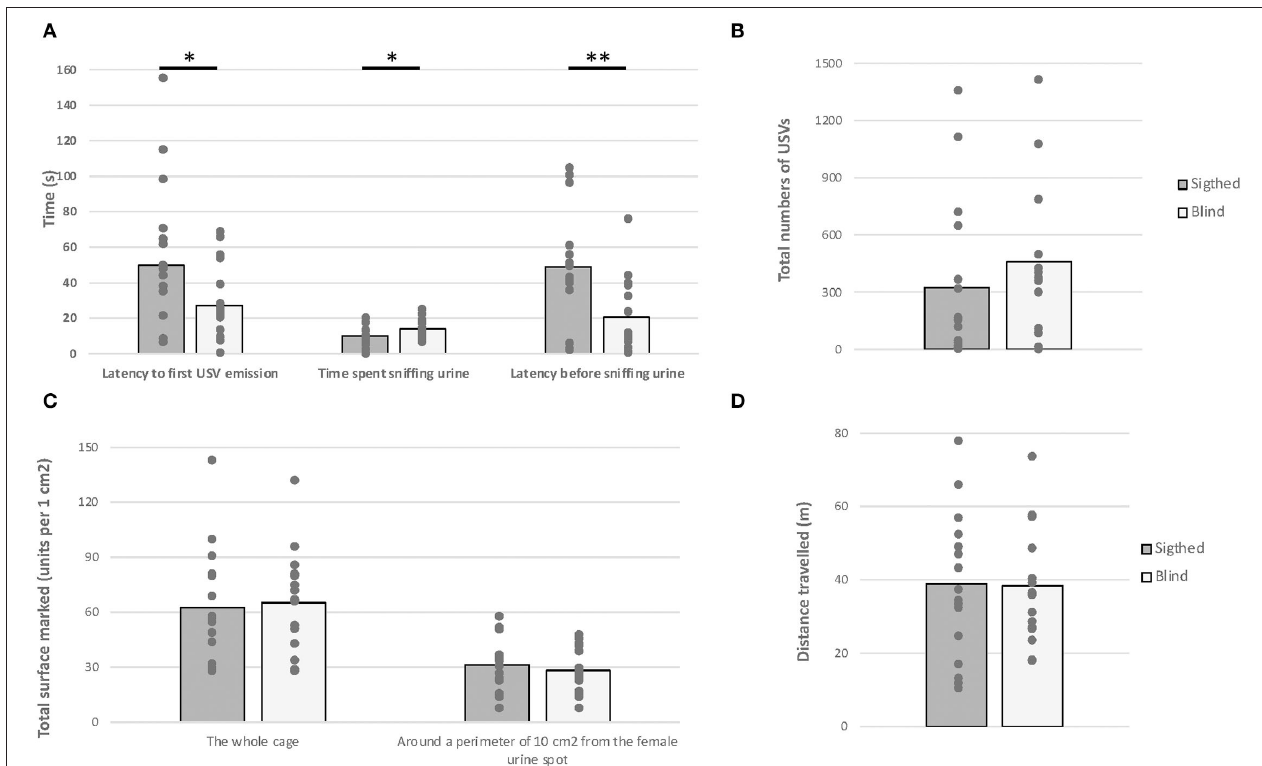
FIGURE 6 | Female urine-induced USVs and scent-marking behavior. Anophthalmic and sighted male mice were exposed to a 100–ml female urine spot for 5 min: (A) The latency before emitting the first USV call, the time spent sniffing the female urine, the latency before sniffing the female urine; (B) the total numbers of USVs emitted; (C) the total number of mark units; and (D) the total distance traveled (* p < 0.05; ** p < 0.01).